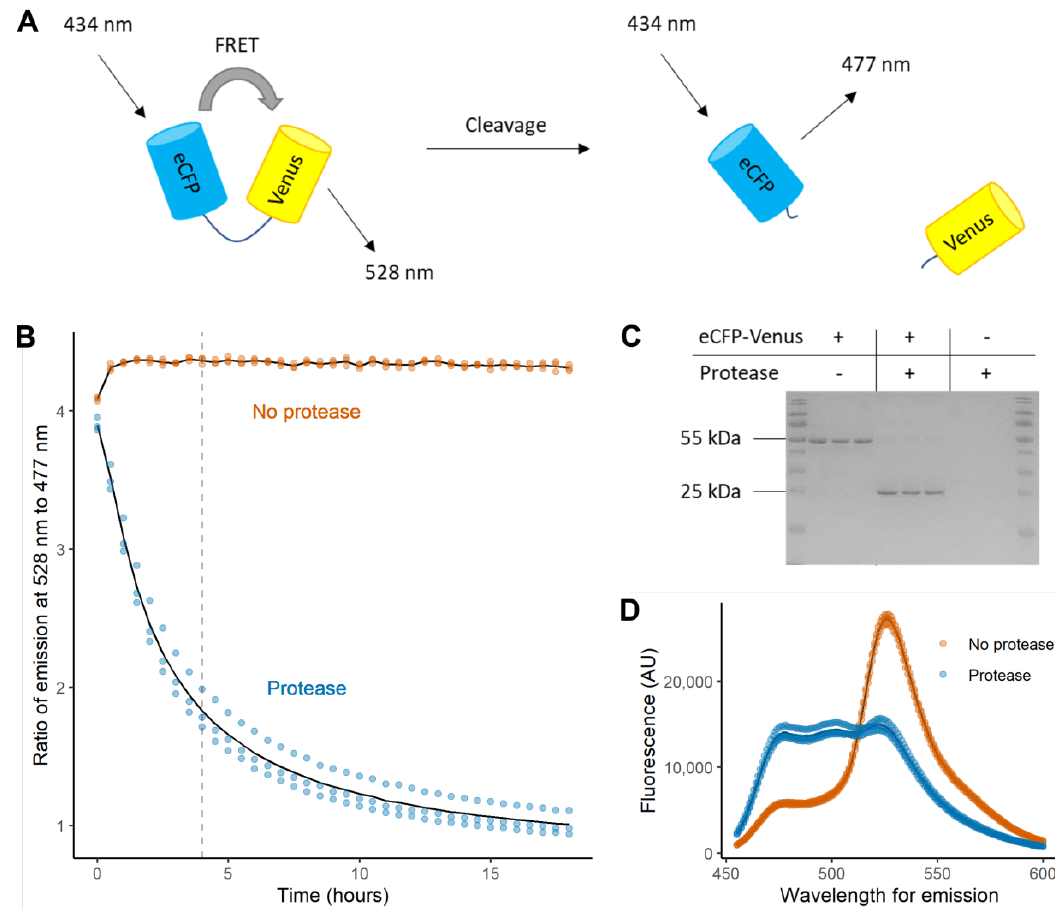
Figure 2. ( A ) When eCFP is excited at 434 nm in the intact biosensor, the close proximity of eCFP and Venus results in FRET emission from Venus at 528 nm. Cleavage of the linker by SARS-CoV-2 3CL pro stops FRET occurring and emission now comes directly from eCFP at 477 nm. ( B ) The dynamic ratio of emission from the FRET acceptor (Venus) and donor (eCFP)(R 528 / 477 ) during treatment with (blue) or without (orange) SARS-CoV-2 3CL pro . The emission of the FRET donor (λ ex eCFP 477 nm) and acceptor (λ ex Venus 528 nm) after excitation at 434 nm were measured at 30 min intervals and used to calculate the R 528/477 . A dashed line at 4 h indicates the time used in endpoint assays for subsequent high-throughput screening. ( C ) A 12% SDS-PAGE gel of samples taken from the reactions measured in Panel B at 18 h. Each well in the SDS-PAGE gel contained a 12 µL sample taken from a 200 µL reaction. The presence of the eCFP-Venus biosensor and protease is indicated above the gel. Bands present at 55 kDa are consistent with the eCFP-Venus biosensor, including intact linker and His 6 -tag (predicted mass of 56 kDa), and bands just above 25 kDa are consistent with monomers of similarly sized eCFP (predicted mass of 27.5 kDa) and Venus (28.5 kDa). ( D ) Emission spectra of the eCFP-Venus biosensor after 18 h of treatment with (blue) and without (orange) protease. Experiments were performed in triplicate using separately purified eCFP-Venus biosensor and SARS-CoV-2 3CL pro . The average between replicates is represented by a line and all datapoints are shown as dots.